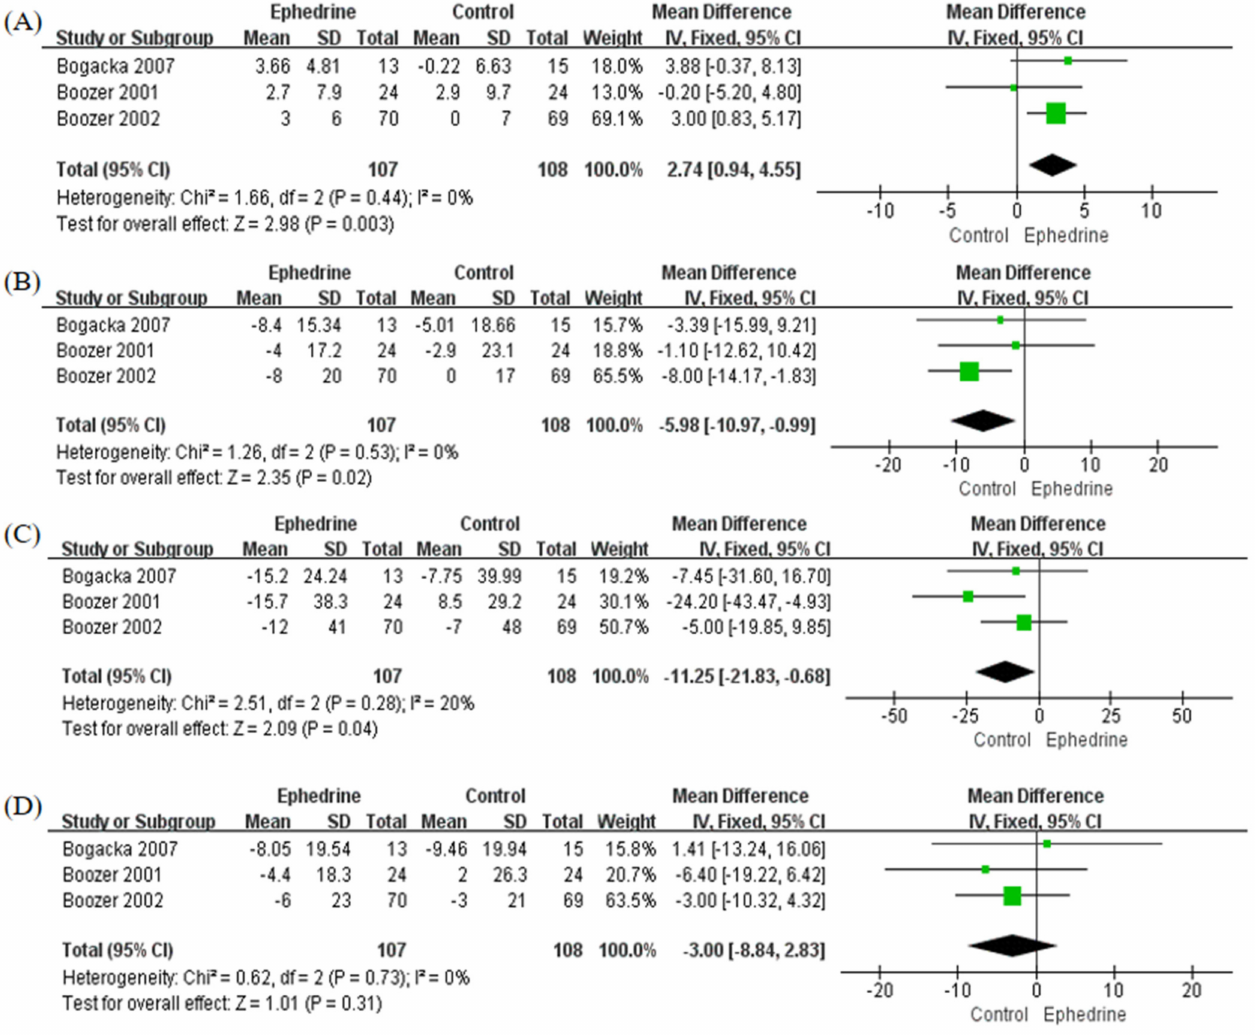
Figure 4. Forest plots to compare lipid profile changes between ephedrine-containing products and placebo in obese or overweight patients. ( A ) High-density lipoprotein cholesterol (mg/dL); ( B ) low-density lipoprotein cholesterol (mg/dL); ( C ) triglycerides (mg/dL); ( D ) total cholesterol